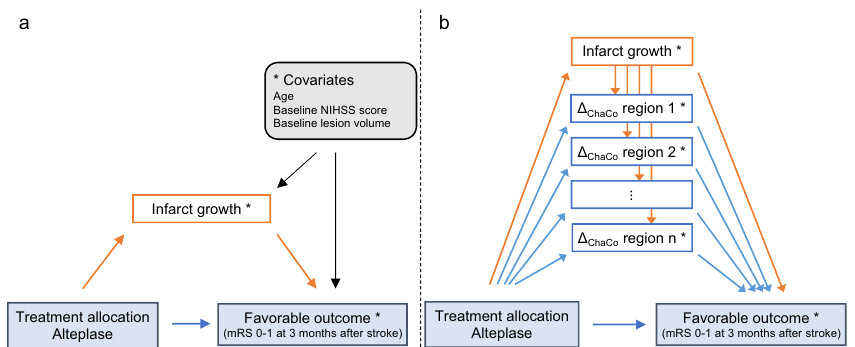
Fig. 5 Diagrammatic representation of the causal models used in mediation analyses of the effect of thrombolysis with alteplase on functional outcome through structural parameters of infarct progression. Favorable clinical outcome was de fi ned as mRS 0 – 1, 3 months after stroke. a Mediation by single mediator infarct growth. b Mediation by progressive loss of local structural connectivity ( Δ ChaCo ) in multiple brain regions. As a post-treatment confounder of the relation between change in connectivity and functional outcome, infarct growth was included as an additional mediator. Adjustment for covariates (age, lesion volume and NIHSS score at baseline prior to randomization) was carried out as marked by the asterisk and indicated explicitly in model a. mRS modi fi ed Ranking Scale; NIHSS National Institute of Health Stroke